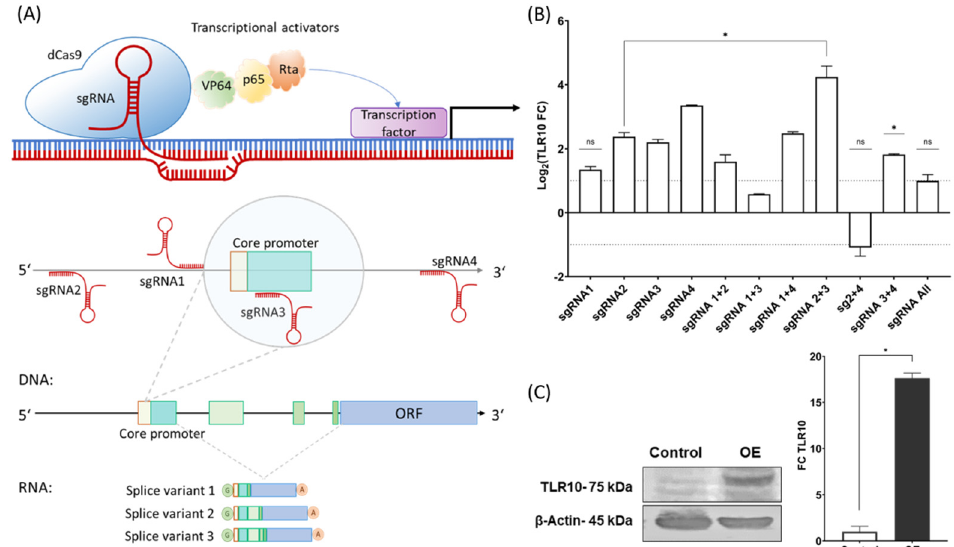
Figure 1. Overexpression of TLR10 using CRISPR/dCas9 system. ( A ) The CRISPR/dCas9 system consists of a catalytically dead Cas9 (dCas9) with fused transcriptional activators (VP64, p65, and Rta) and a single guide RNA (sgRNA). The genomic segment represents the human TLR10 locus on chromosome 4 (complement 38,772,238–38,782,990 GRCh38.p13 assembly). Four sgRNAs were de-